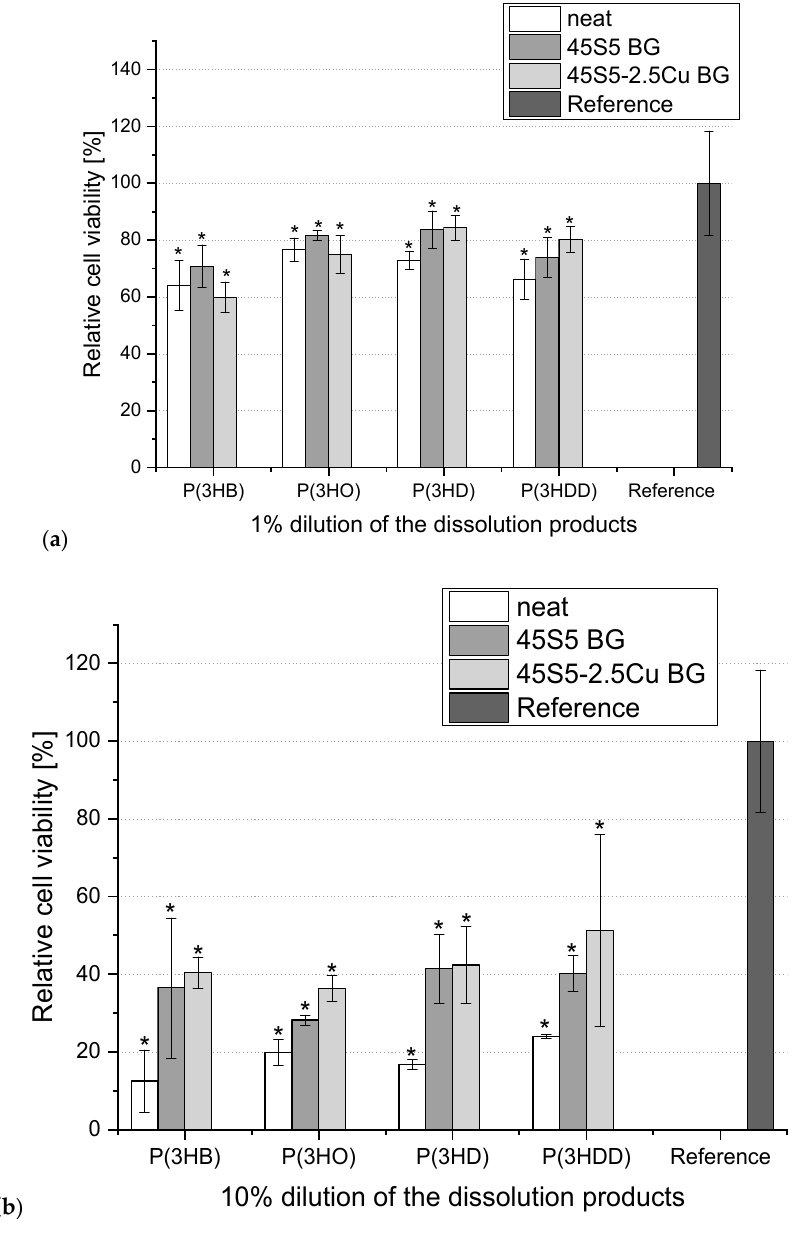
Figure 2. Relative viability of ST2 cells cultured in media containing 1% ( a ) and 10% ( b ) dilution of ionic dissolution products (IDPs) from different BG-PHA and neat PHA scaffolds. One-way ANOVA statistical analysis denotes significant differences compared to the reference (*p < 0.05). As reference pure CCM was used (Bonferroni’s post hoc test was used).